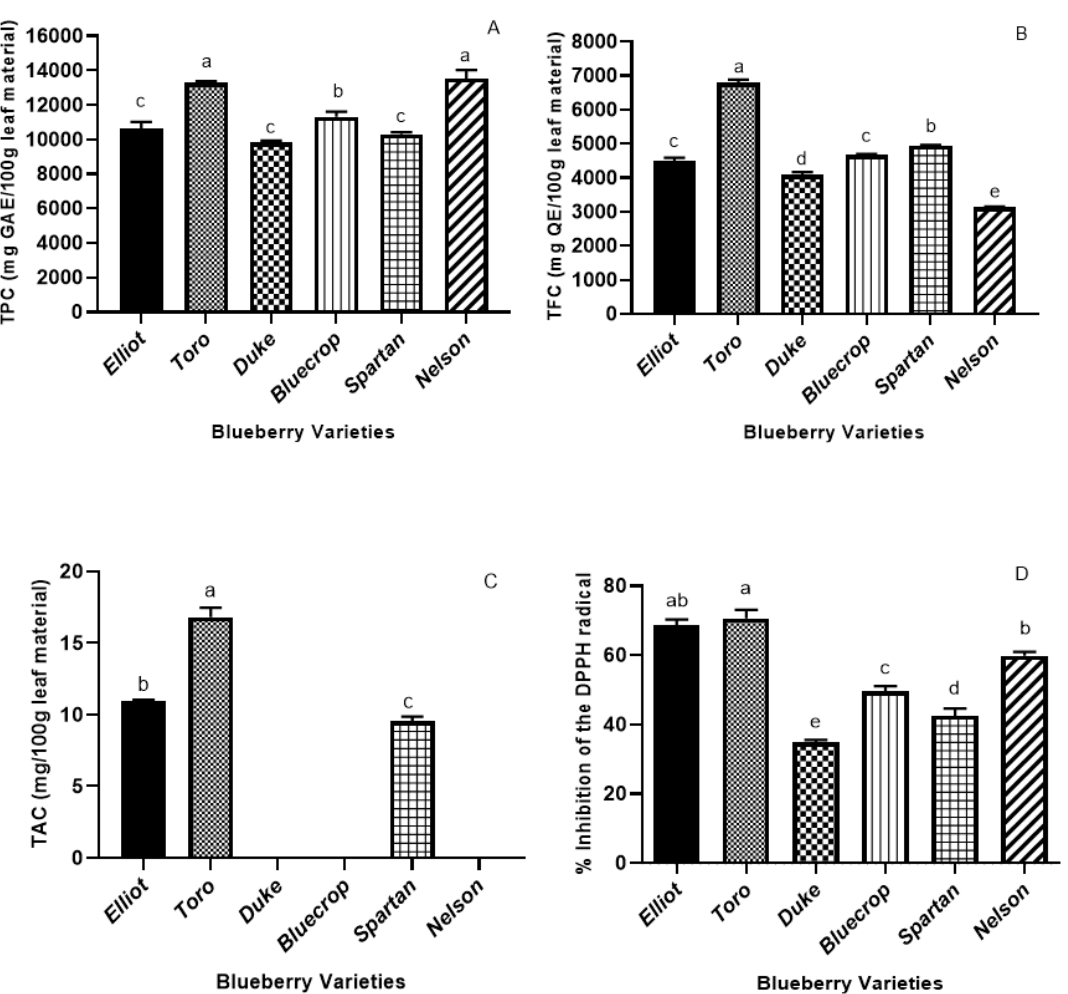
Figure 1. Total phenolic content (Folin–Ciocalteu method) ( A ), total flavonoid content ( B ), total anthocyanin content ( C ), and DPPH antioxidant activity ( D ) of the leaf extracts from the six commercial blueberry varieties. The total phenolic content of the extract is expressed as gallic acid equivalents (GAE) in mg/100 g leaf material. The total flavonoid content is expressed as quercetin equivalents (QE) in mg/100 g leaf material. Values (means ± SD, n = 3) followed by different letters (a–e) indicate significant differences ( p < 0.05) between the six varieties (One-way ANOVA-Tukey multiple range tests).